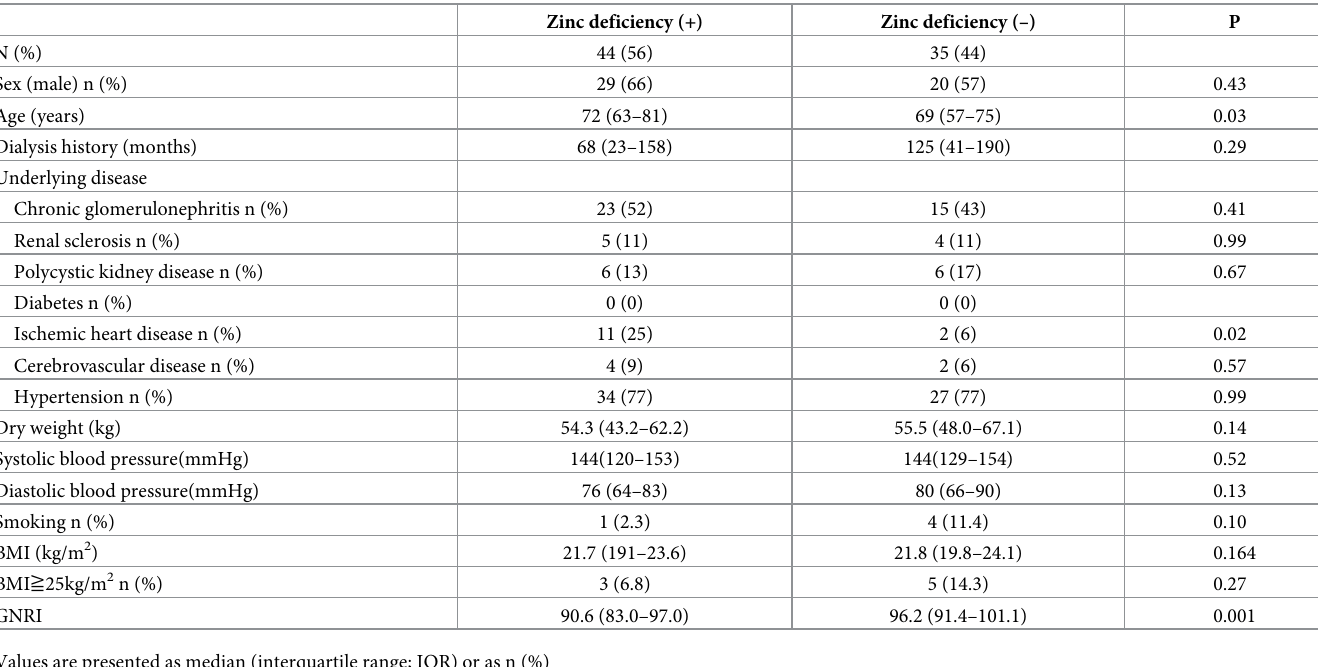
Table 1. Patient backgrounds of the zinc deficiency and non-deficiency